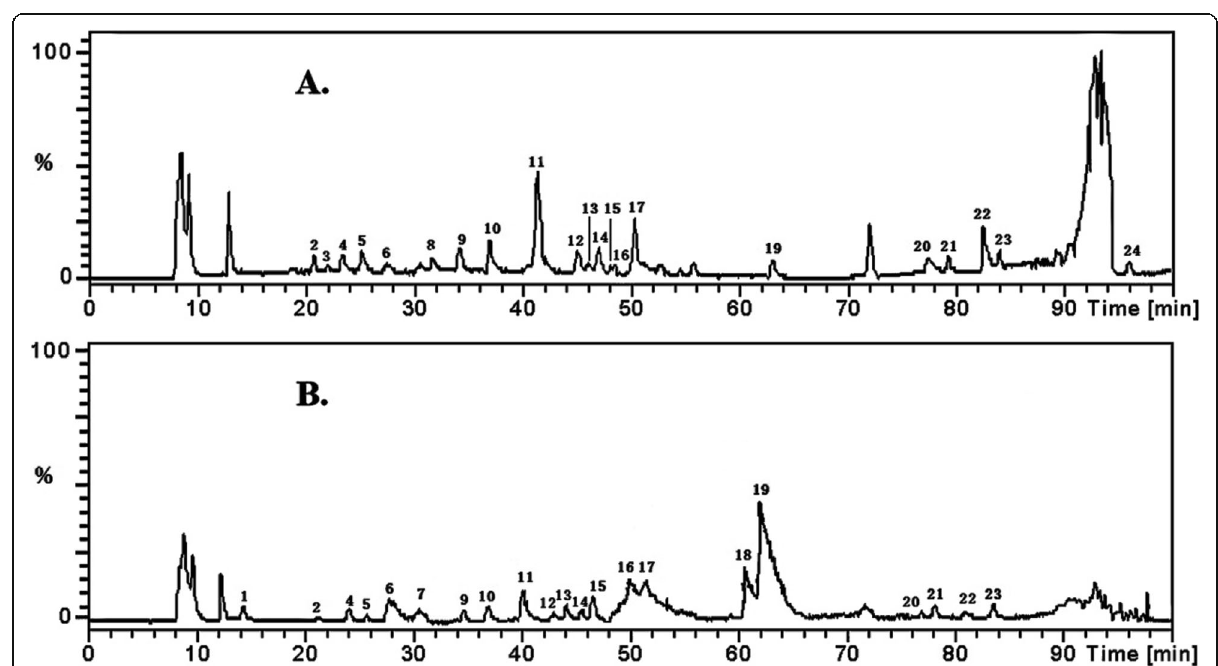
Fig. 3 The TIC of drug-containing serum after administration of Erhuang decoction extracts. a TIC in negative ESI mode. b TIC in positive ESI